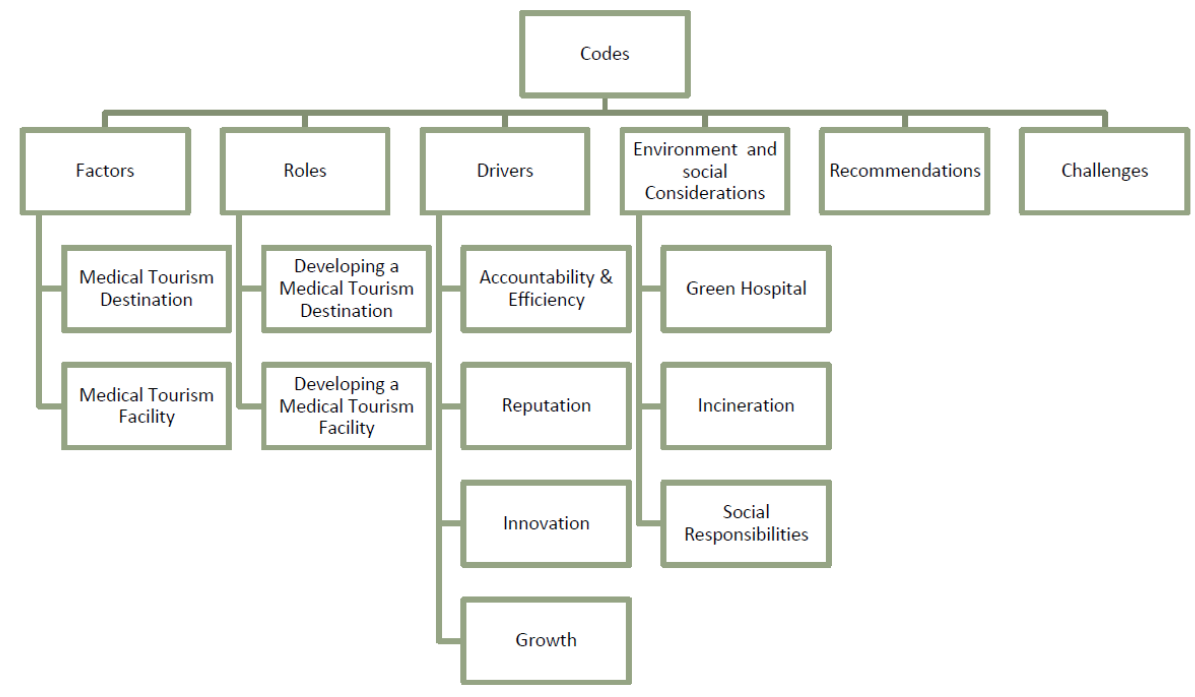
Figure 1. Data structure .